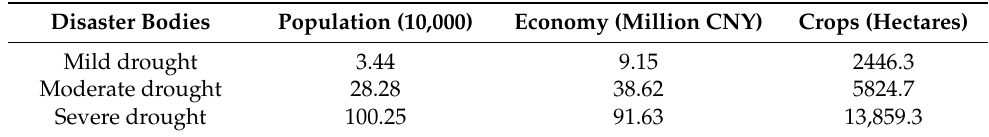
Table 7. Socioeconomic risks of droughts in Cangnan County.